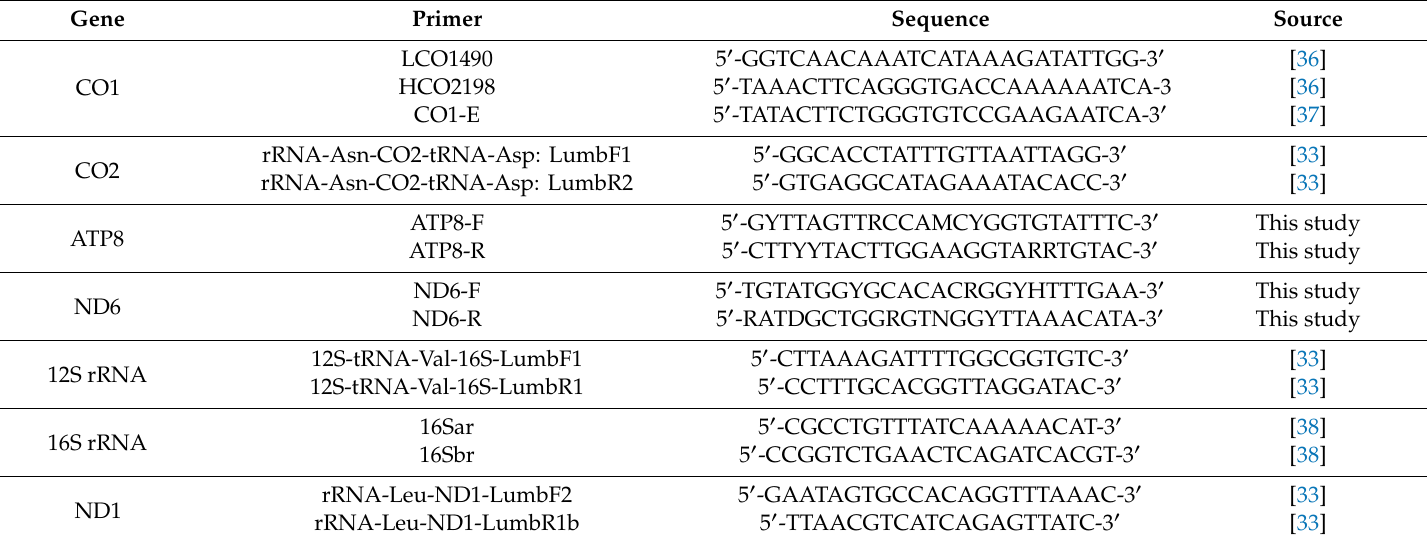
Table 2. Primers used for PCR and